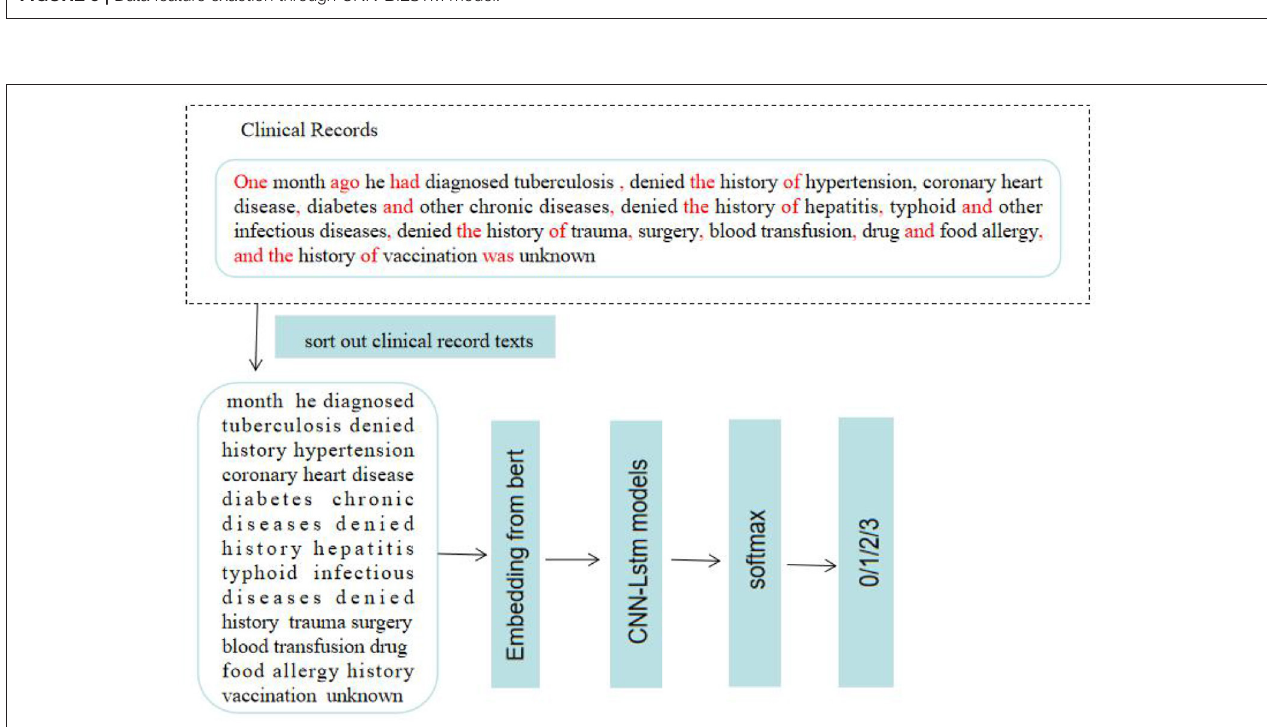
FIGURE 6 | The process of disease identification. Based on machine learning to predict and diagnose respiratory diseases. 0: PTB; 1:COPD; 2: PTE; 3: bronchiectasis.